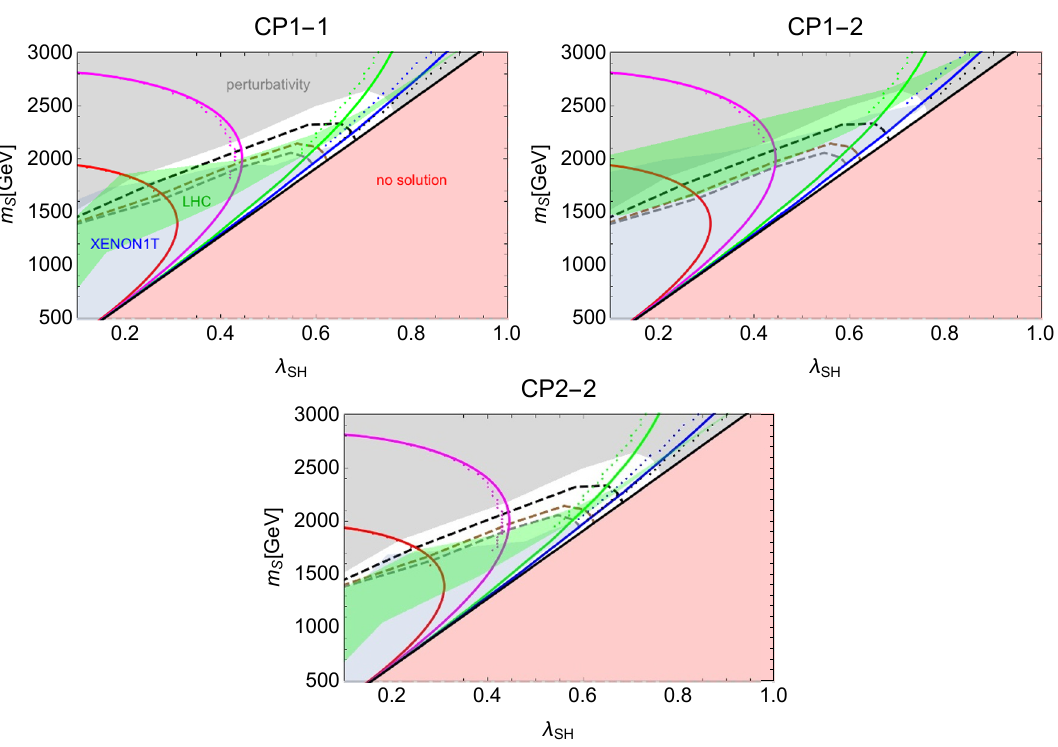
Figure 6 . Correlation between λ SH and m S for v φ = 2 . 5 TeV (red), 3 TeV (magenta), 4 TeV (green), 5 TeV (blue), and 10 TeV (black). All the points on each curve satisfy Ω S h 2 = 0 . 12 . The upper- left, upper-right, and lower panels show the results for CP 1-1, CP 1-2, and CP 2-2, respectively. The dotted and solid curves correspond to the calculation by micrOMEGAs and that using the fitting function eq. (3.5), respectively. Shaded regions are respectively excluded by eq. (3.6) (red), the perturbativity bound (gray), the XENON1T experiment (blue), and the LHC data (green). Regarding the perturbativity bound, the absence of Landau pole up to µ = 10 17 GeV is imposed. When we impose eq. (3.7) instead, the region above the black dashed curve is